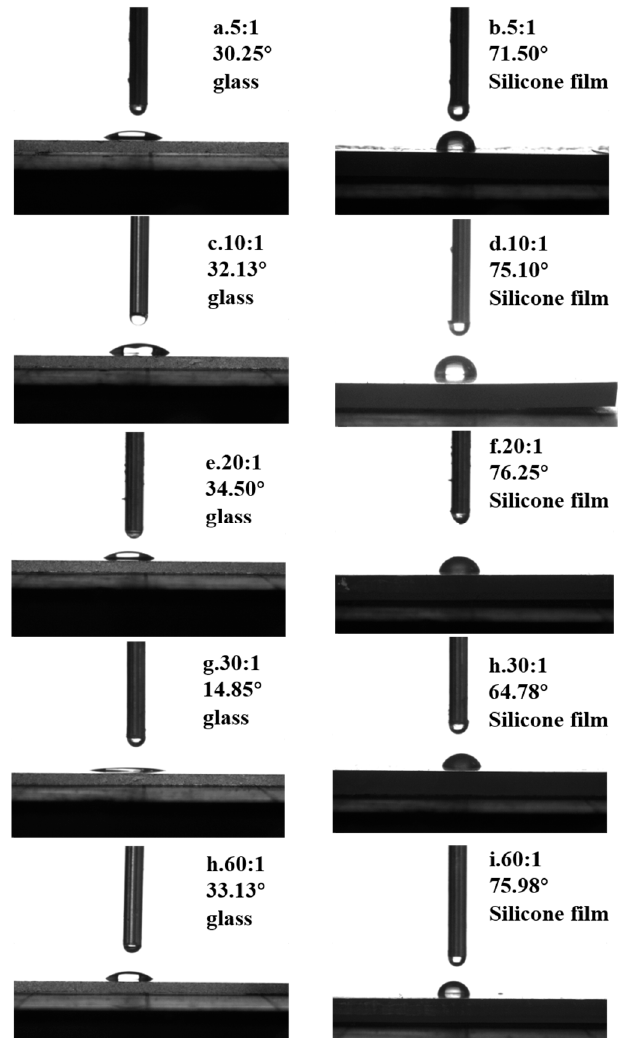
Figure 5. The results of determination of contact angle.